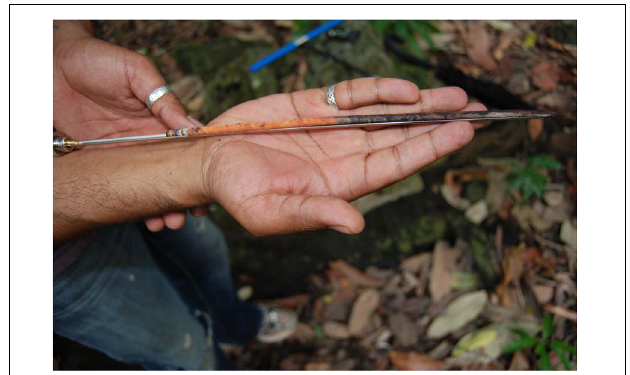
FIGURE 6 | A wood core extracted from an endemic ebony tree for dendrochronology, Bras d’Eau Sugar Estate. Although banding of the rings is faint, typical of tropical hardwoods, the image illustrates the potential for use of this species as part of a dendrochronology dating program.